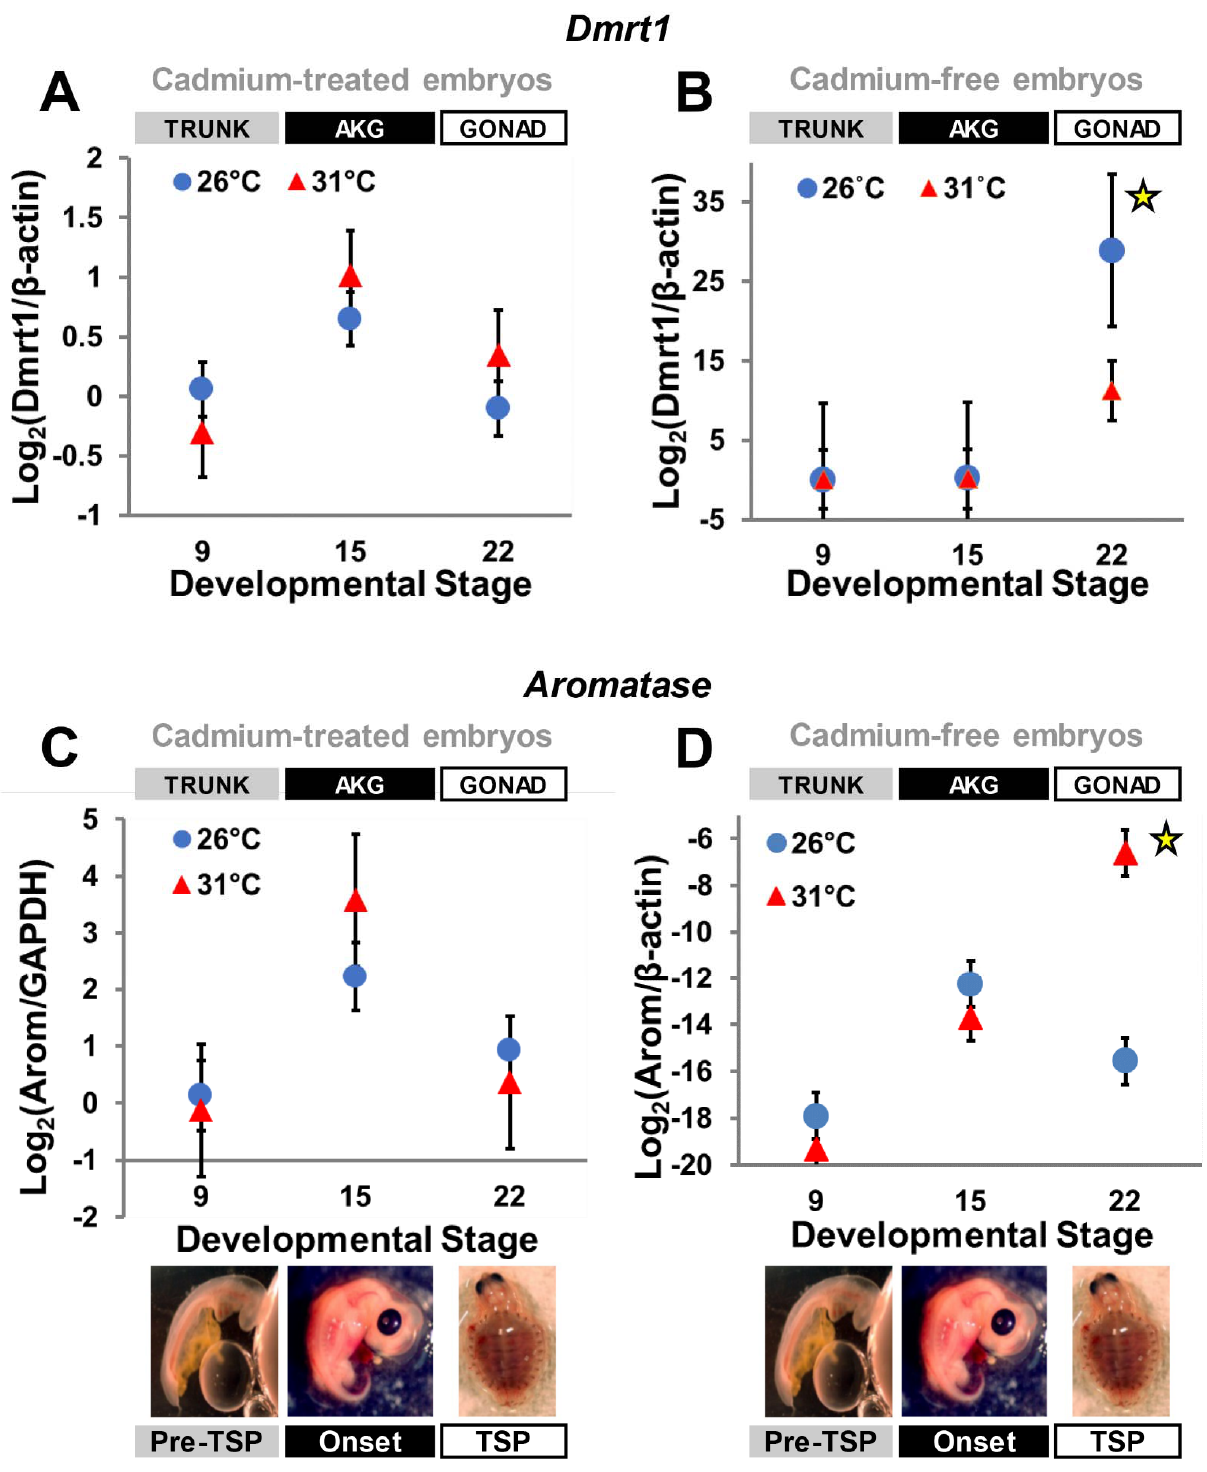
Figure 2. Dmrt1 and aromatase transcription under and without cadmium exposure. Data derived from this study ( A , C ), and from Mizoguchi and Valenzuela 2020 [38] ( B ) and Valenzuela et al. 2013 [28] ( D ), which serve as negative control. Bars represent standard deviations. In embryos exposed to cadmium ( A , C ), differences in expression between temperatures were not significant at any of the stages examined, whereas in the absence of cadmium exposure, Dmrt1 ( B ) and aromatase ( D ) are normally upregulated at stage 22 at MPT or FPT, respectively (indicated by the yellow star